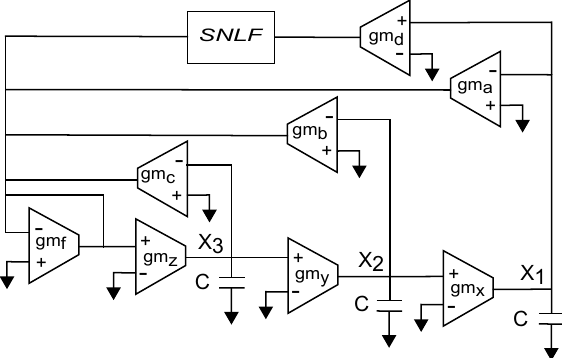
Figure 2. OTA-based implementation of Equation (3), where SNLF represents the PWL function in current mode h i ()